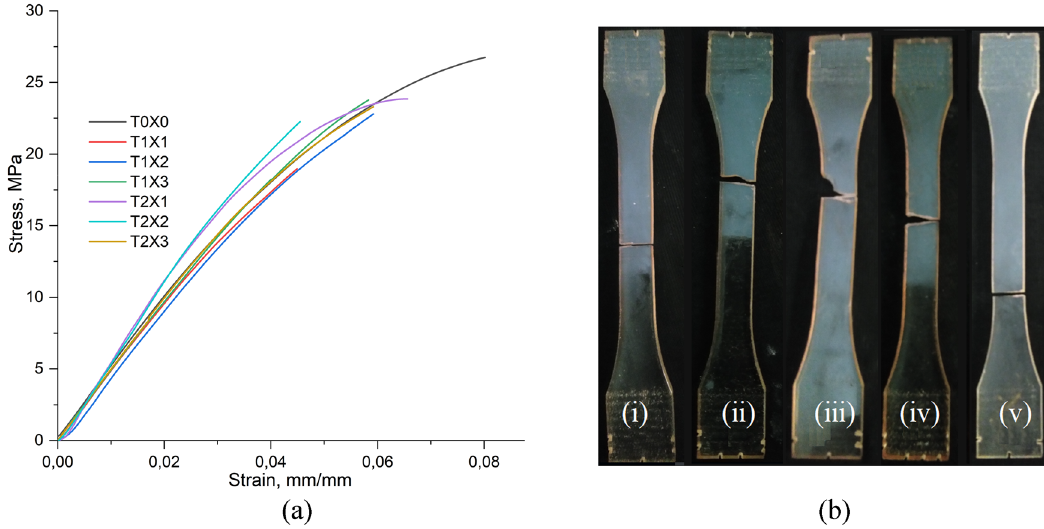
Figure 6: ( a ) Stress to strain curve and ( b ) tensile fracture patterns of epoxy resin specimen: ( i ) T0X0, ( ii ) T1X2, ( iii ) T2X2, ( iv ) T1X3, and ( v ) T2X1.